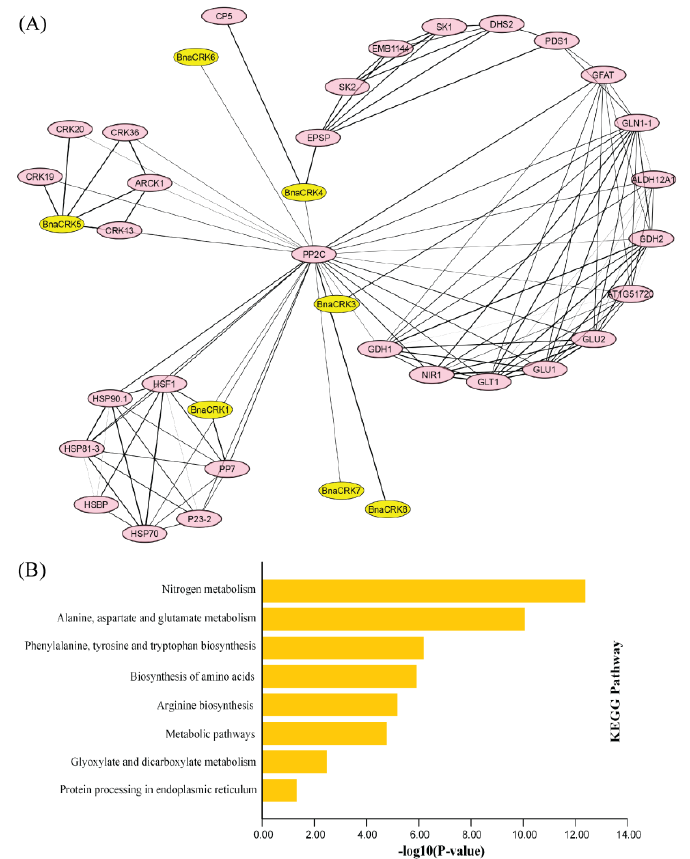
Figure 6. Protein interaction network of the BnaCRKs based on the A. thaliana orthologs. ( A ) Stronger interactions are shown by thicker lines. ( B ) KEGG pathway analysis of the BnaCRKs interacting targets.